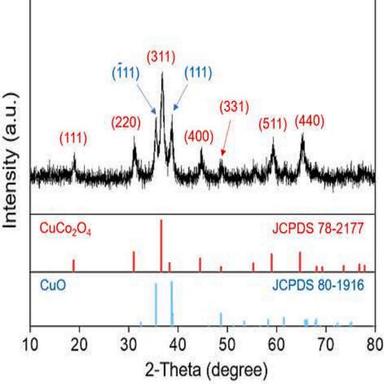
The XRD pattern of CuCo2O4/CuO microspheres.